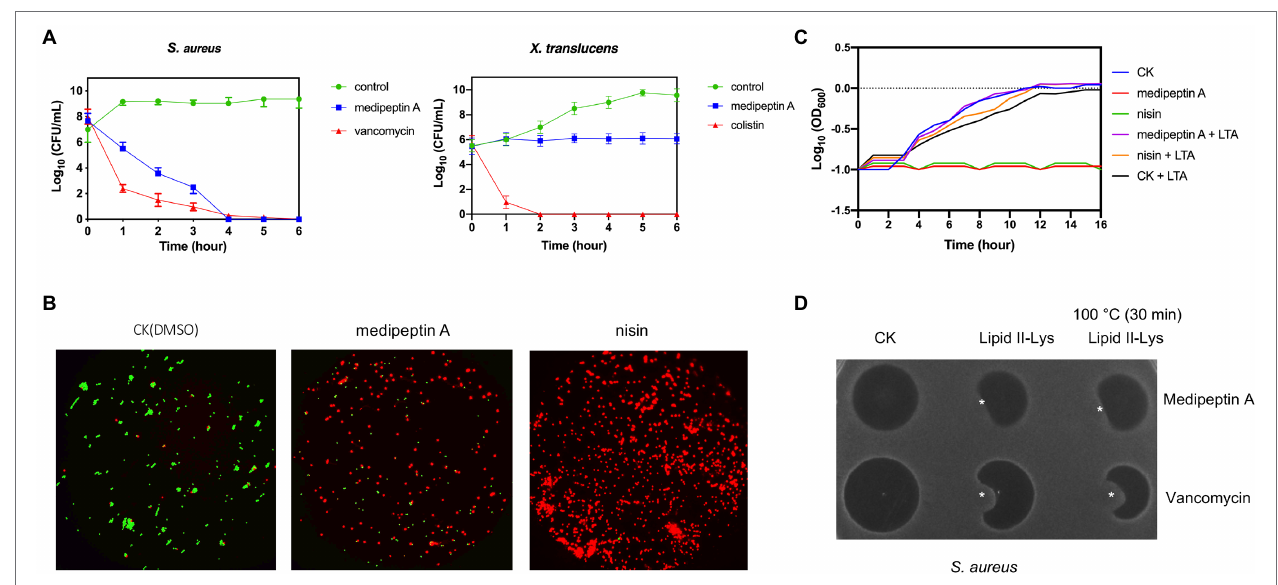
FIGURE 4 | Investigation of the mode of action of medipeptin A. (A) Time killing curve of medipeptin A (10X MIC) to S. aureus and X. translucens pv. graminis. (B) Membrane permeability of medipeptin A (5X MIC) to S. aureus . Nisin was added at a concentration of 2.5 μ g/ml, and the same amount of DMSO was treated as control. Cells with a compromised membrane integrity were stained in red, while cells with intact membrane were stained in green. (C) Medipeptin A binds to LTA. Medipeptin A (24 μ g/ml 3X MIC) was added to each well, and the same volume of DMSO was used as a negative control. Nisin (2 μ g/ml) was used as a positive control. (D) Medipeptin A binds to lipid II (Gram-positive lipid II, lipid II-Lys). Medipeptin A was added at a concentration of 200 μ g/ml; vancomycin was added at a concentration of 200 μ g/ml; *the position of lipid II-Lys was added at a concentration of 300 μ M, 4 μ